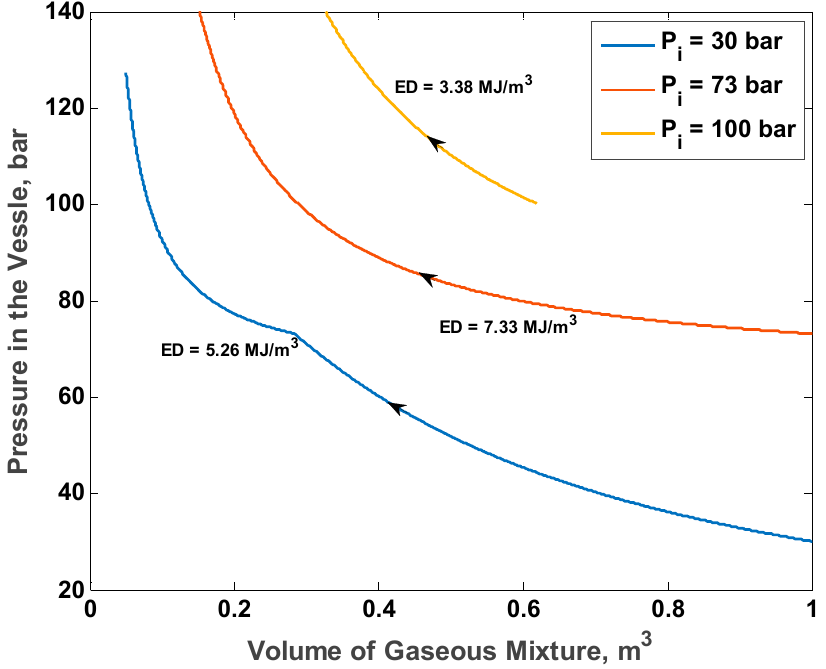
Figure 9. P–V diagram for initial total CO 2 mole fraction = 88% and three different initial pressures: minimum, optimal, and maximum.